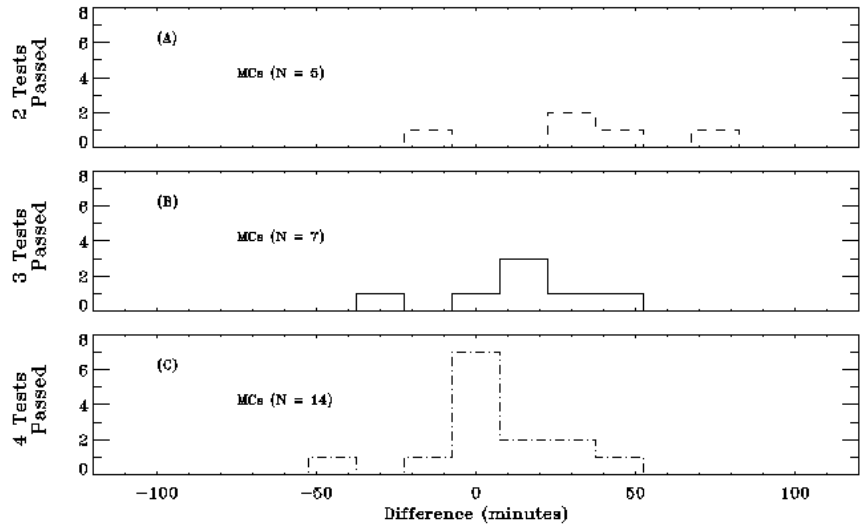
Fig. 4. Histograms of 1t =[ t B *(test)– t B (VI)] for the N =26 MCs of Data Set #1 that passed a given number of tests, up to the full number of four tests for the 5min averages. We know from Fig. 2a that no events occurred in either the “zero tests passed” or the “one-test passed” categories. But 5 events passed the two-test category and their 1t ’s are shown here in (A) . (B) Shows the specific 7 1t ’s that were associated with the three-tests-passed case. Likewise, (C) here gives the distribution of 1t ’s for the 15 events that passed all four tests.